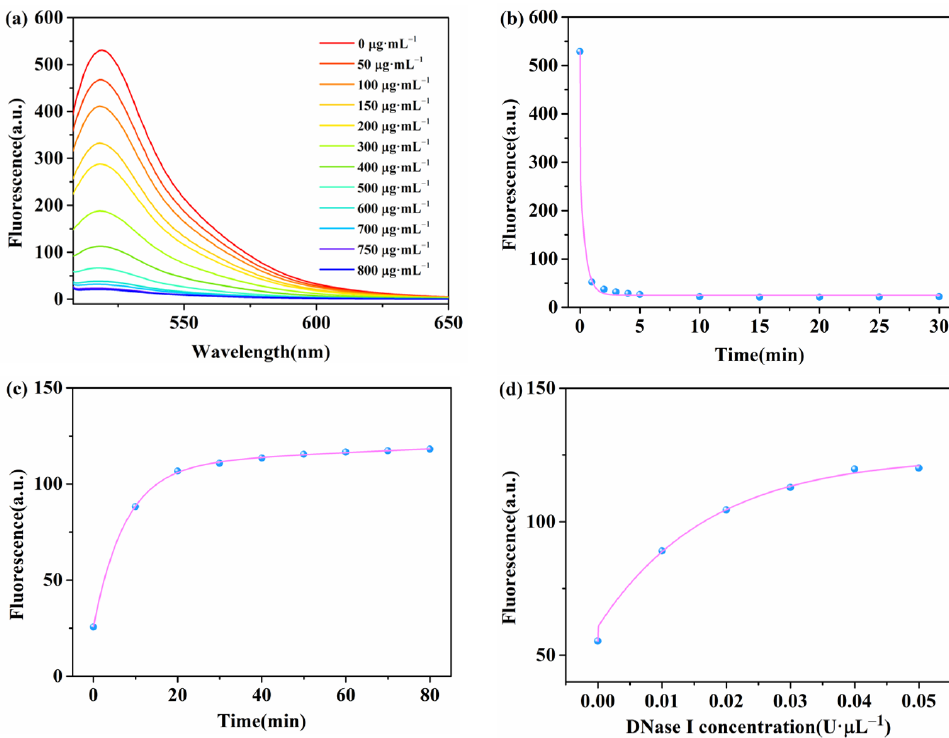
Figure 3. ( a ) Fluorescence spectra of β-Lg aptamer after adding different concentrations (from a to l: 0, 50, 100, 150, 200, 300, 400, 500, 600, 700, 750, and 800 μg·mL −1 ) of WS 2 nanosheets. ( b ) Fluores- cence intensity of β-Lg aptamer in response to various times. ( c ) Effect of recovery time on the fluo- rescence response of the β-Lg (10 μg·mL −1 ) detection system. ( d ) Effect of enzyme concentration on the fluorescence response of the β-Lg (10 μg·mL −1 ) detection